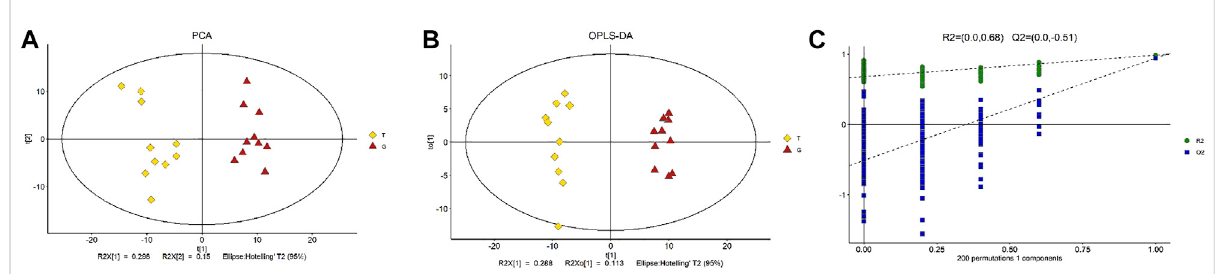
FIGURE 2 Multivariate statistical score graph. (A) PCA score plot of differential metabolites. (B) OPLS-DA score plot of differential metabolites. (C) Statisticalvalidationwithpermutation analysis(200 times)ofthecorrespondingPLS-DAmodel.R2istheexplained variance,andQ2isthepredictive ability of the model.